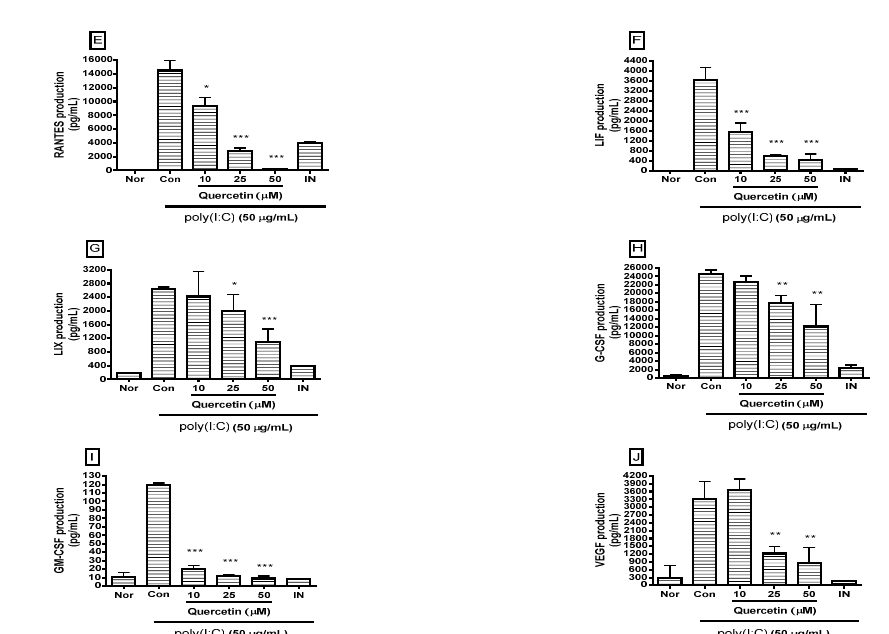
Figure 3. Effect of quercetin on production of cytokines, such as interleukin (IL)-6 ( A ); tumor necrosis factor (TNF)- α ( B ); monocyte chemoattractant protein-1 (MCP-1) ( C ); interferon gamma-induced protein-10 (IP-10) ( D ); RANTES ( E ), leukemia inhibitory factor (LIF) ( F ); lipopolysaccharide-induced CXC chemokine (LIX) ( G ); granulocyte-colony stimulating factor (G-CSF) ( H ); granulocyte macrophage-colony stimulating factor (GM-CSF) ( I ); and vascular endothelial growth factor (VEGF) ( J ) in dsRNA-induced RAW 264.7 mouse macrophages. Flourescene intensity of each cytokine in the culture medium was measured by a multiplex bead-based cytokine assay after the 24 h incubation. The normal group (Nor) was treated with media only. The control group (Con) was treated with 50 µ g/mL of the dsRNA synthetic analog polyinosinic-polycytidylic acid (poly(I:C)) alone. IN, indomethacin (0.5 µ M). Values are mean ± standard deviation of three independent experiments. * p < 0.05 vs. Con; ** p < 0.01; *** p < 0.001. Significant differences were examined using one ‐ way analysis of variance test followed by Tukey’s multiple comparison test.